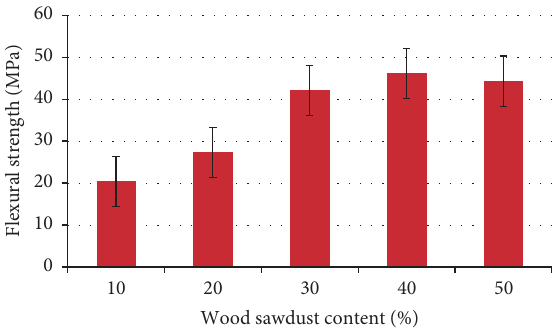
Figure 4: Effect of sawdust content on flexural strength.